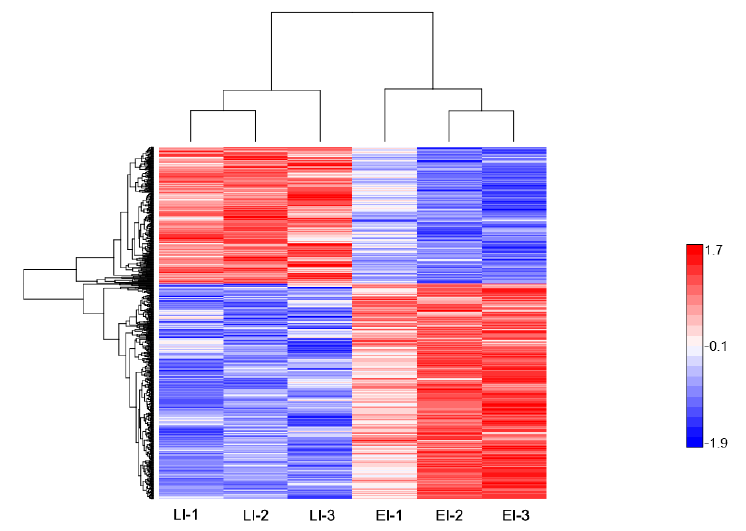
Figure 5. Hierarchical clustering of differentially-expressed proteins at the late disease stage. Heat map showing the changes in protein expression: proteins with high expression levels (red); proteins with low expression level (blue).